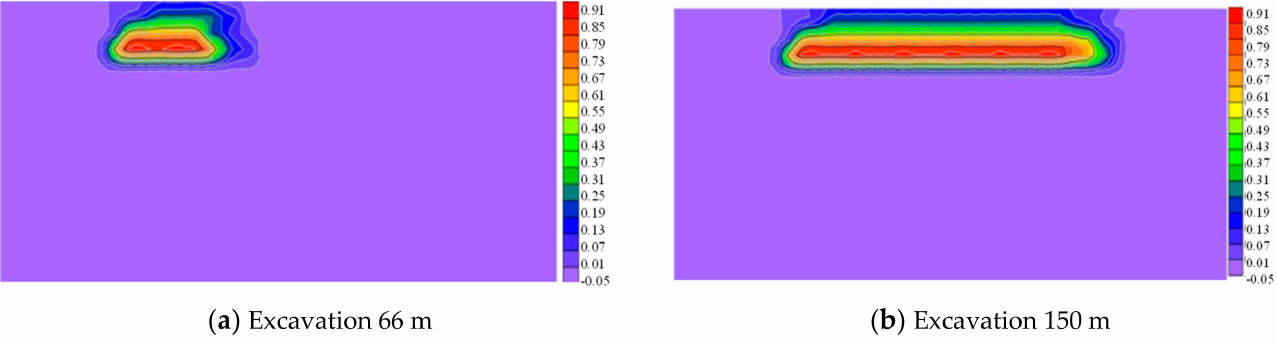
Figure 6. Characteristics of overburden movement and deformation during the mining of the 3# coal seam.